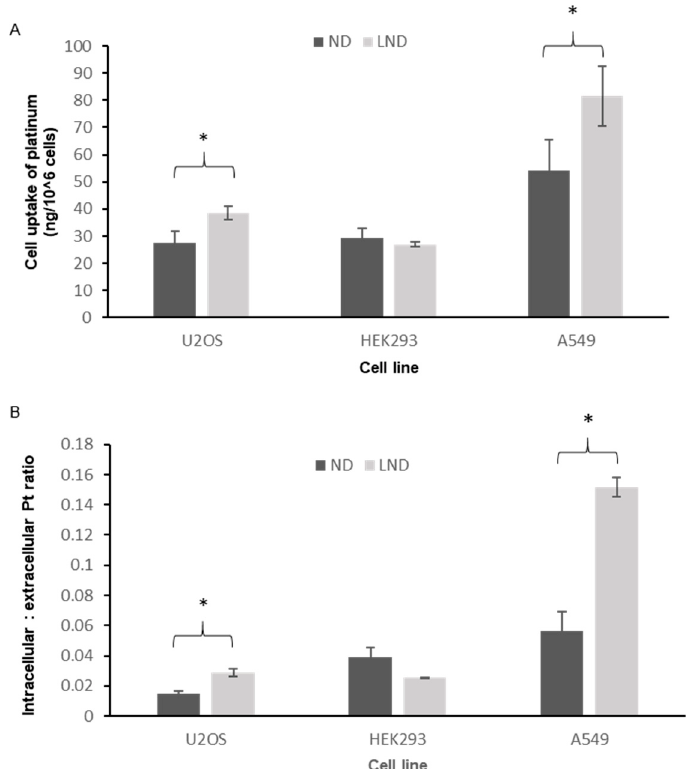
Figure 2. Uptake of platinum by cancer and noncancer cells. ( A ) Total platinum uptake (ng) in samples of one million treated cells accurately quantified by ICP MS. ( B ) Platinum uptake ratios (intracellular: extracellular platinum) in cancer and noncancer cells. In both cases, a statistically significant increase in cellular uptake of platinum with PEGylated liposomal nedaplatin (LND) compared to ND was observed specifically in the cancer cells lines ( p -value < 0.05). Multiple pair-wise t -tests showed the cell lines where a significant di ff erence in platinum uptake between LND and ND was observed. These points are indicated by asterisks * ( p < 0.05) in the charts above.